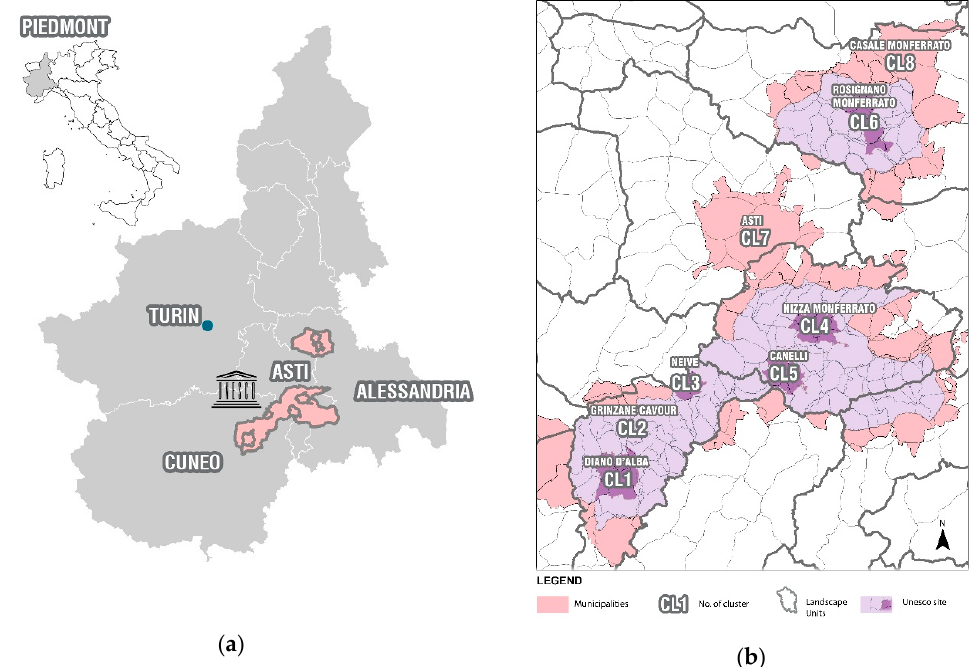
Figure 2. Territorial localization of the LRM landscape (a) and system of territorial clusters of the vineyard landscape are included the core zones and the buffer zones of the UNESCO site (b).